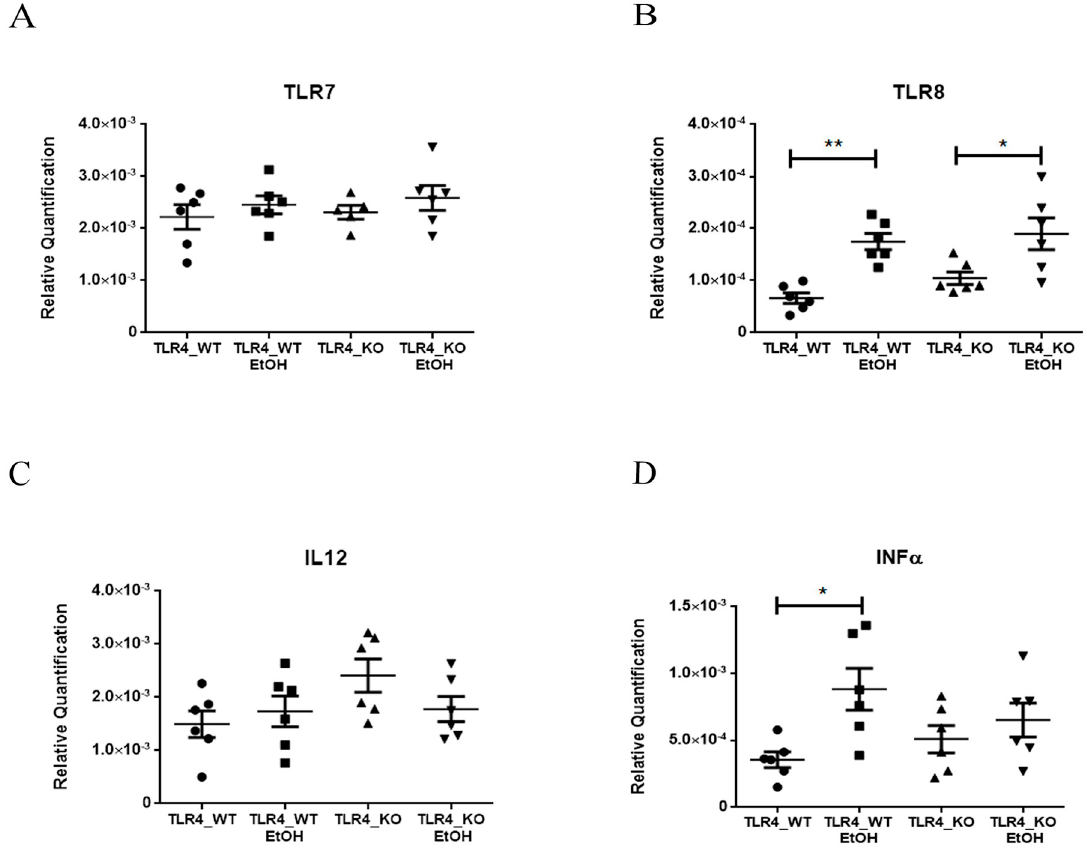
Fig 6. Lack of TLR4 dismisses INF α activation by TLR7/8 Receptors. ( A-D ) The RT-qPCR analysis of the WT and TLR4-KO mice cortices with and without EtOH treatment, the relative quantification of receptors TLR7/8, Interleukin IL12 and INF α showed a differential expression of TLR8 by the ethanol inflammatory effect in both genotypes, but alcohol led to the activation of INF α only in the WT mice. A statistical analysis was performed by a two-way ANOVA with n = 6. Statistical significance with a p-value of � < 0.05 and �� <